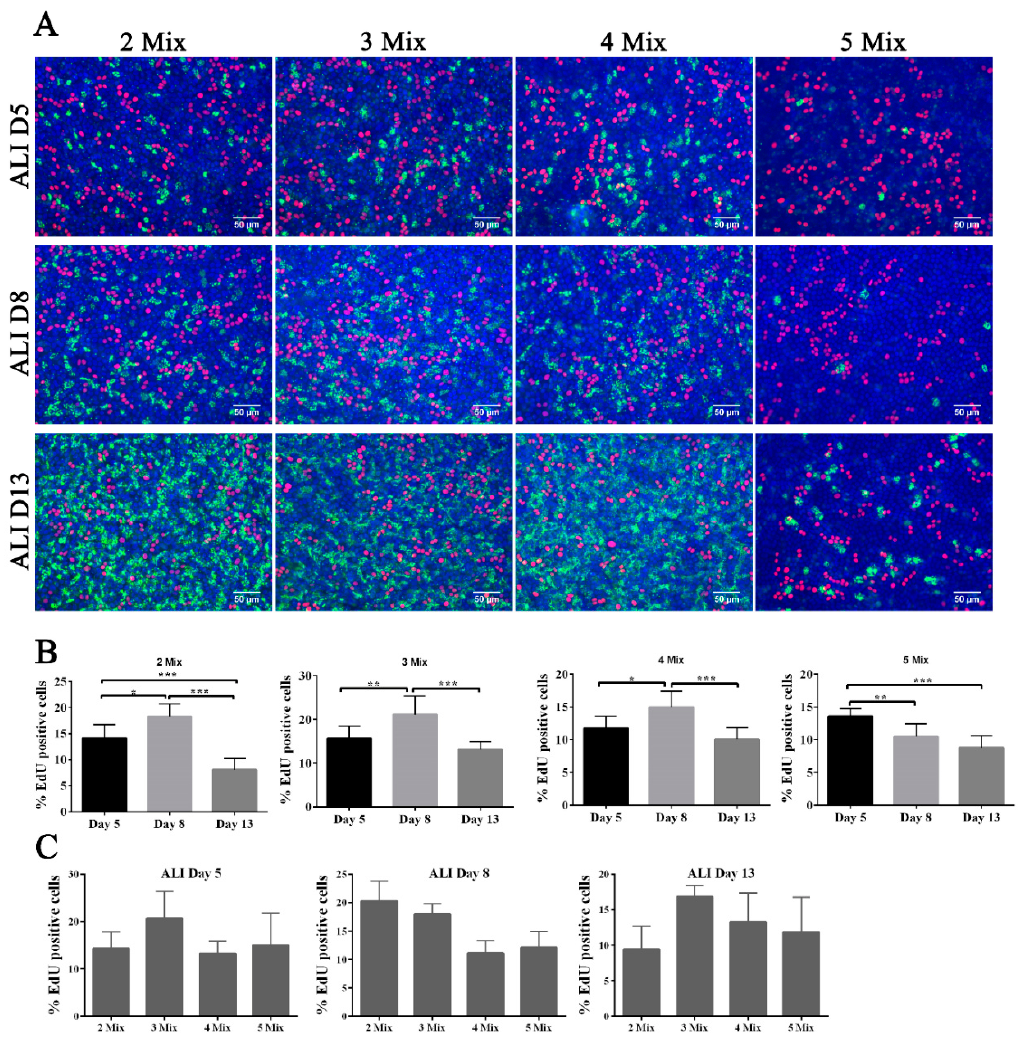
Figure 5. Effects of each factor in basal medium on fallopian tube epithelial cell (FTEC) differentiation and self-renewal. ( A ) FTECs were cultured in the different medium 2 Mix (B27, GlutaMAX), 3 Mix (B27, GlutaMAX, nicotinamide), 4 Mix (B27, GlutaMAX, nicotinamide, SB431542), and 5 Mix (B27, GlutaMAX, nicotinamide, SB431542, EGF), and exposed to ALI culture conditions. EdU (5 µ M) was added to each group 48 h before the fixation on ALI culture days 5, 8, and 13. Fixed cells were stained for with anti-Ac-tubulin antibody (green), DAPI (blue), and processed for EdU staining (red). Scale bars: 50 µ m. ( B ) Analysis of time-dependent EdU-positive cells in each culture medium using ALI culture conditions. ( C ) The number of EdU-positive cells were calculated in each medium on ALI culture days 5, 8, and 13. * p < 0.05, ** p < 0.01, and *** p <